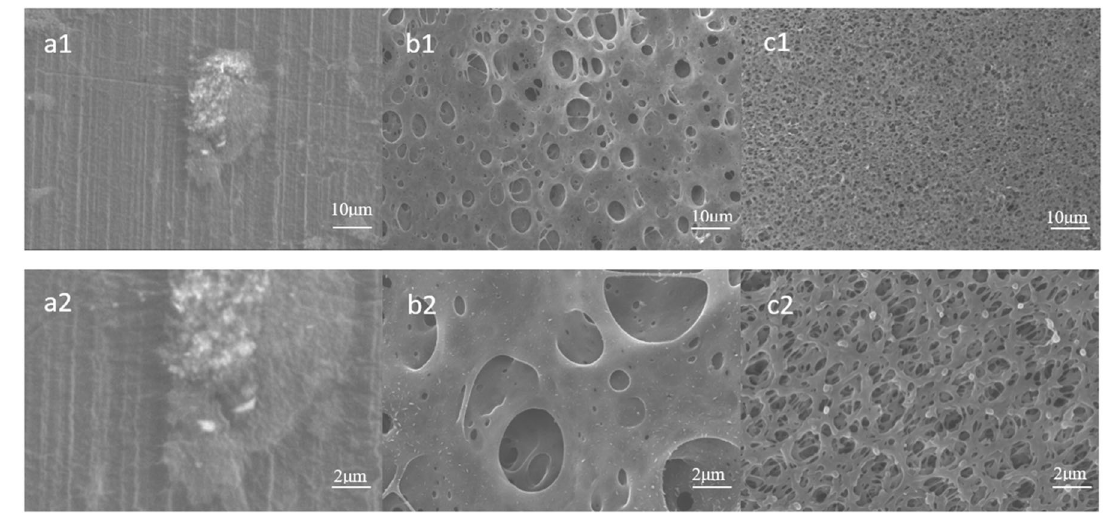
Fig. 2 FE-SEM observations of PEEK and PEEK after sulfonation ( a ) pure PEEK; ( b ) PEEK sulfonated for 5 min; ( c ) PEEK sulfonated for 10 min